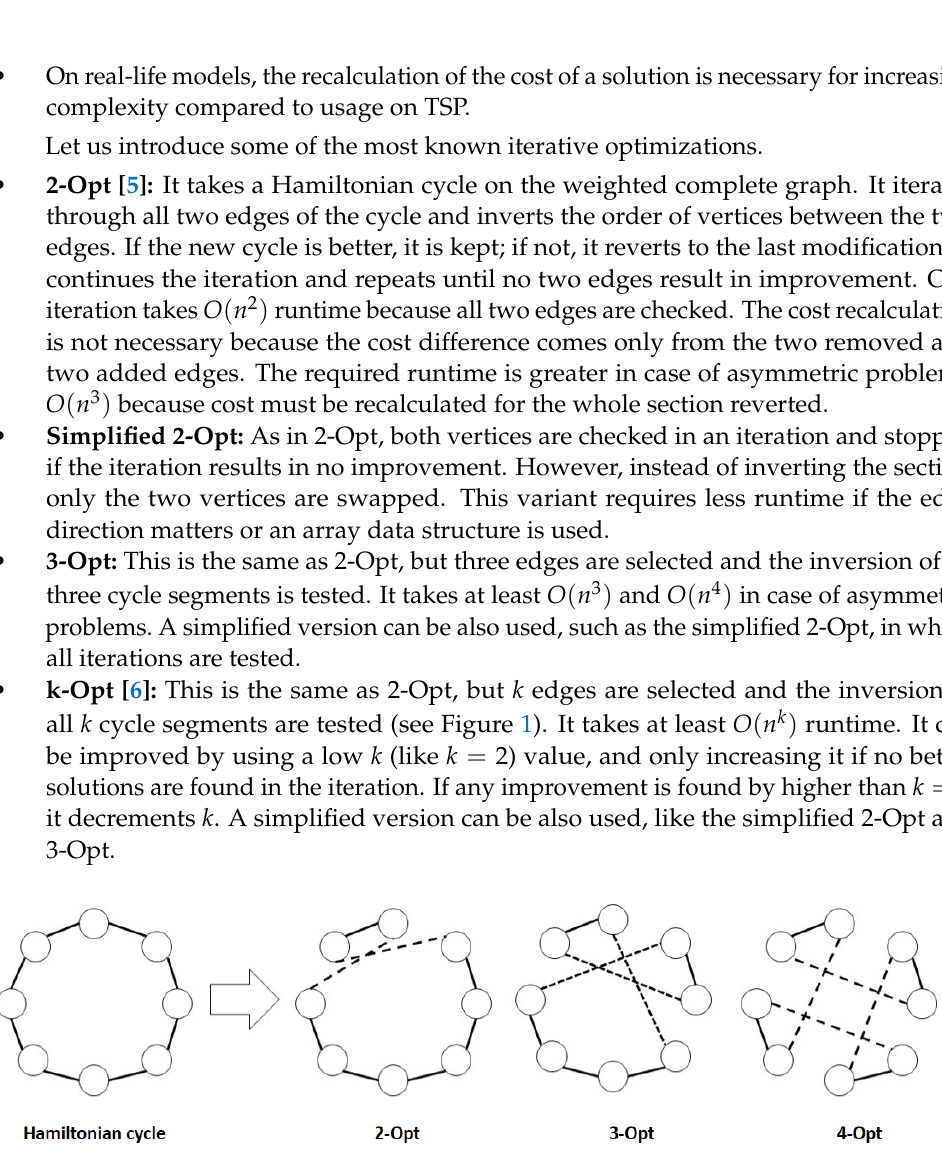
Figure 1. K-Opt Algorithm Family. Here, the dashed lines represent the new edges of the cycle created by the different